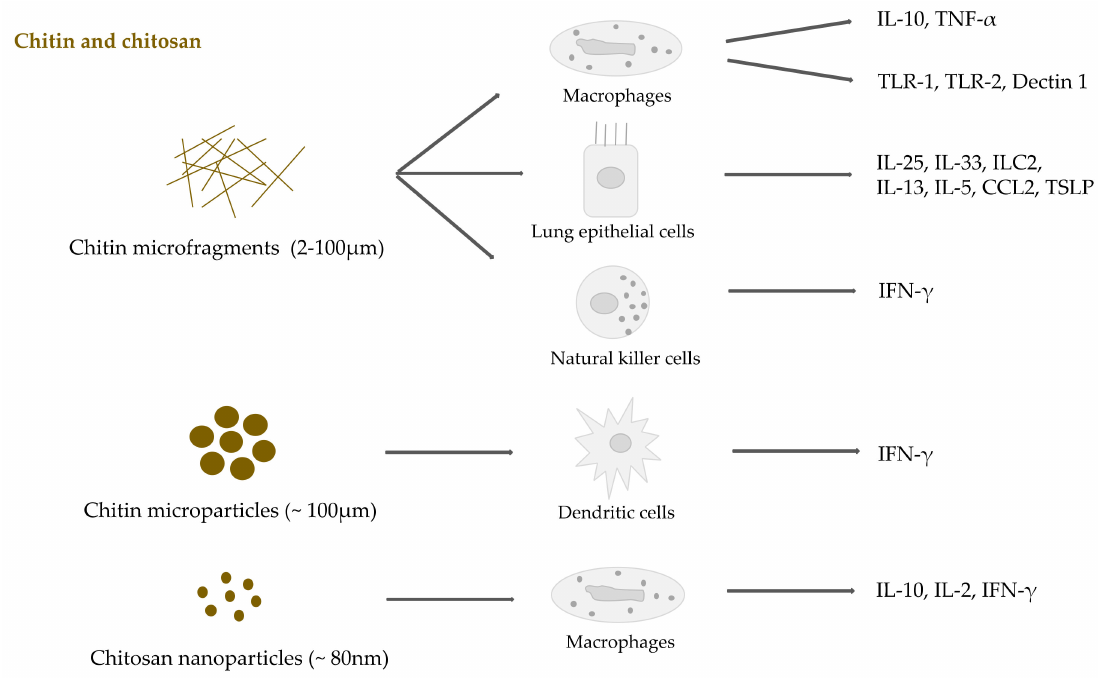
Figure 6. Cytokine release and receptor expression induced by chitin and chitosan NMs.